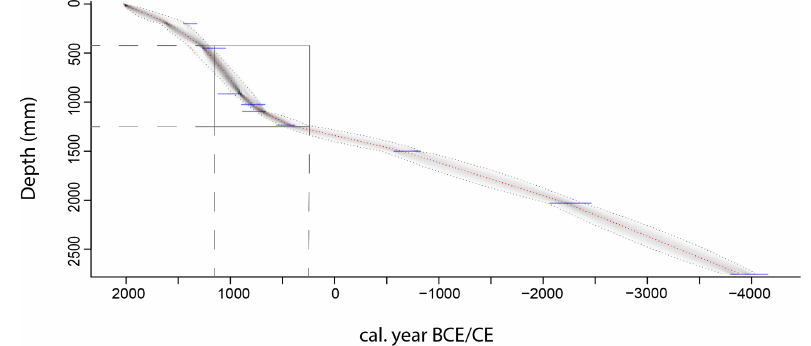
Figure A6. Age–depth model of Haraldstadmyr peat sequence, represented with the RBacon package. The section in the rectangle indicates the study period 250–1150CE.